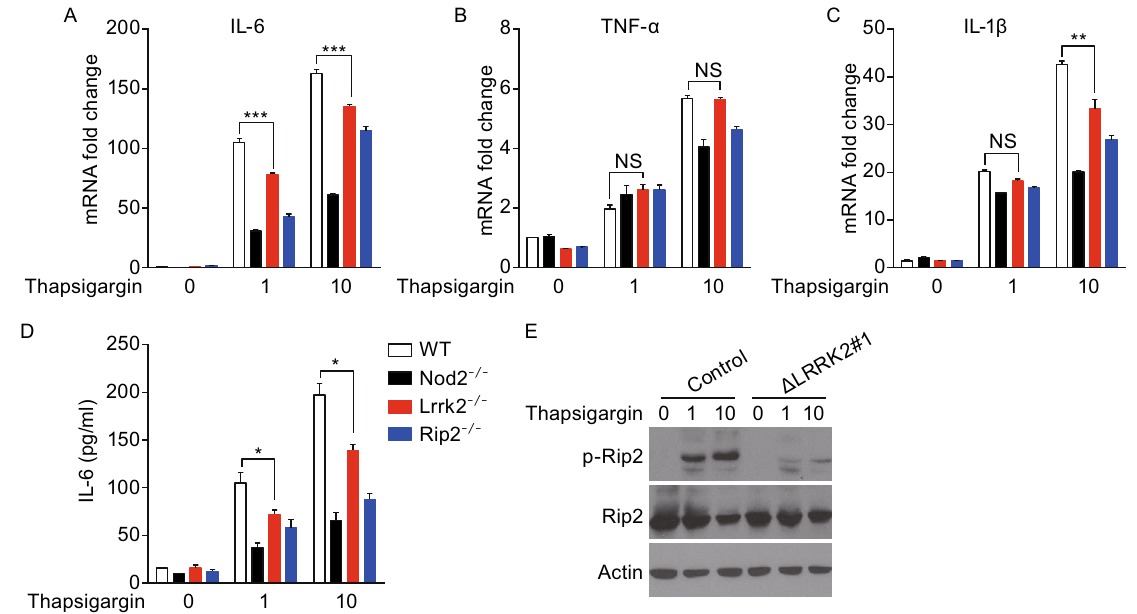
Figure 7. LRRK2 modulates cytokine production during ER stress. (A – C) The relative fold changes of IL-6 (A), TNF- α (B), IL-1 β (C) mRNA transcript levels in WT, Nod2 − / − , Rip2 − / − and Lrrk2 − / − BMDMs treated with 1 or 10 μ mol/L Thapsigargin for 24 h, or mock- treated. (D) The amounts of IL-6 in supernatants from WT, Nod2 − / − , Rip2 − / − and Lrrk2 − / − BMDMs treated as in (A). Data are expressed as mean ± s.e.m. * P < 0.05, ** P < 0.01, *** P < 0.001, NS denotes not signi fi cant, by Student ’ s t -test. (E) The levels of phosphorylated Rip2 and total Rip2 were immunoblotted in control THP-1 cells and THP-1 cells with LRRK2 knockout ( Δ LRRK2 #1) treated with 1 or 10 μ mol/LThapsigargin for 24 h. Actin was used as loading controls. Data are representative of three independent experiments